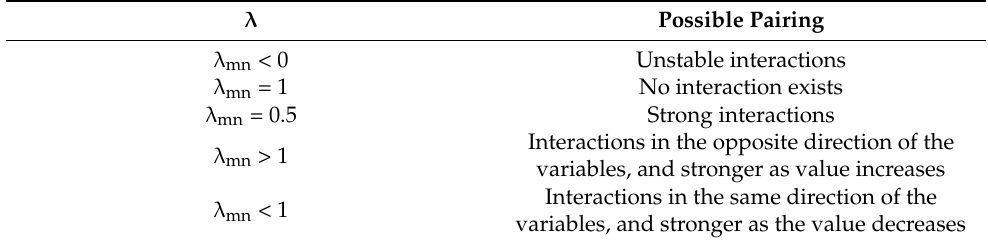
Table 4. Relative gain array effect.